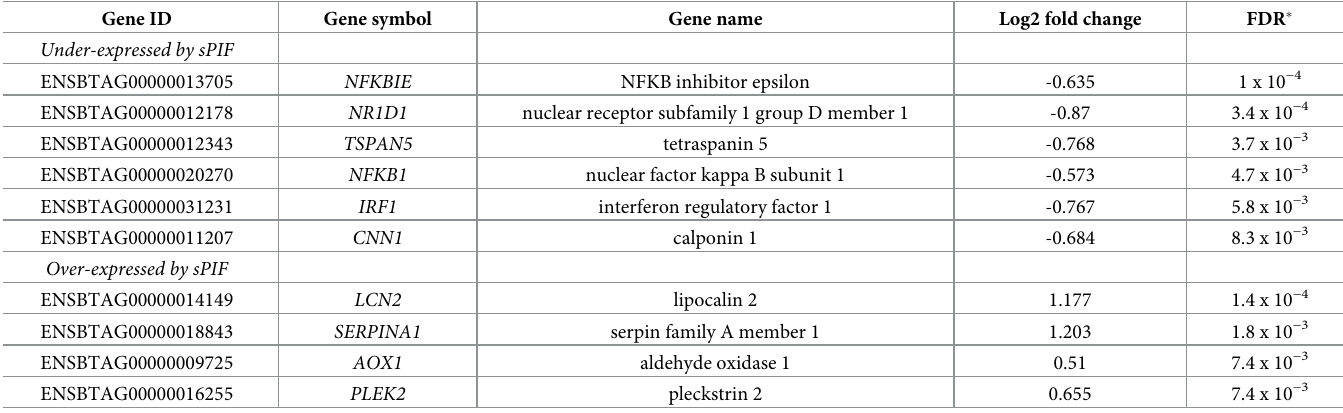
Table 1. Top 10 most significantly DEGs from the control, following sPIF treatment. Gene